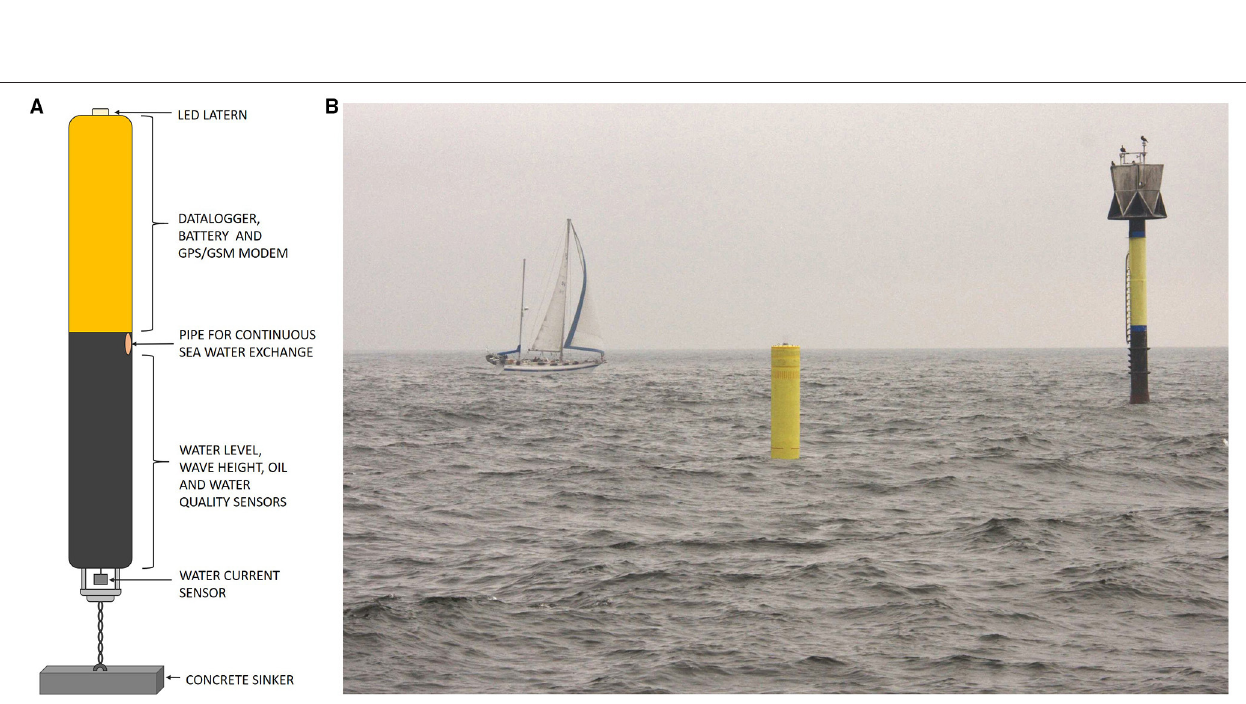
Frontiers in Marine Science |